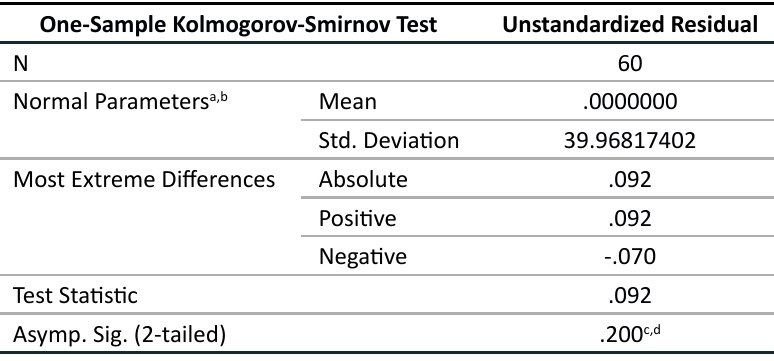
Table 3: Normality Test Result